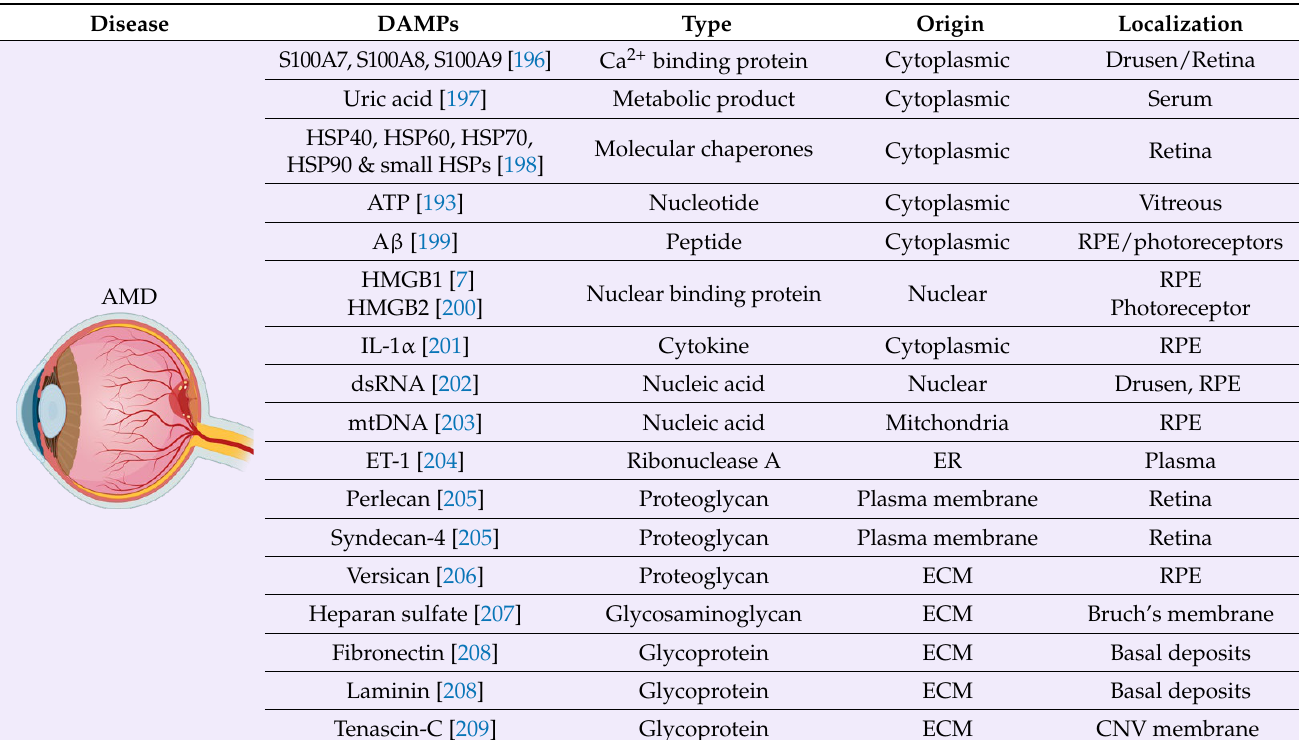
Table 7. DAMPs in age-related macular degeneration.